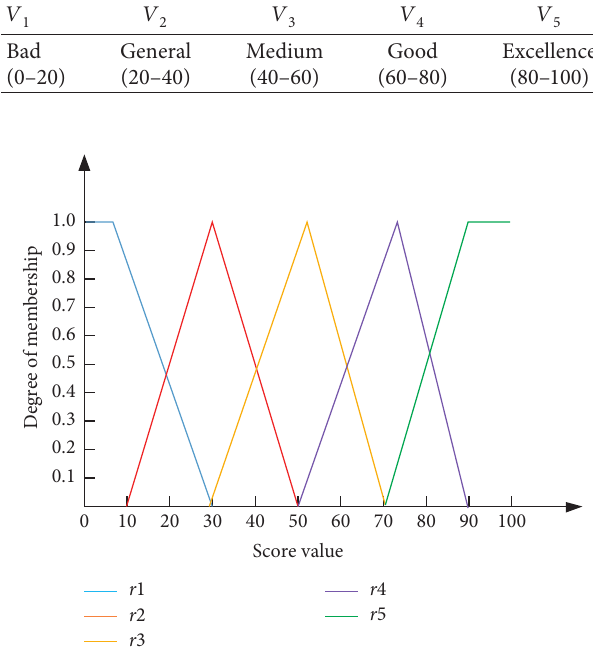
Figure 4: Membership degree functions of road